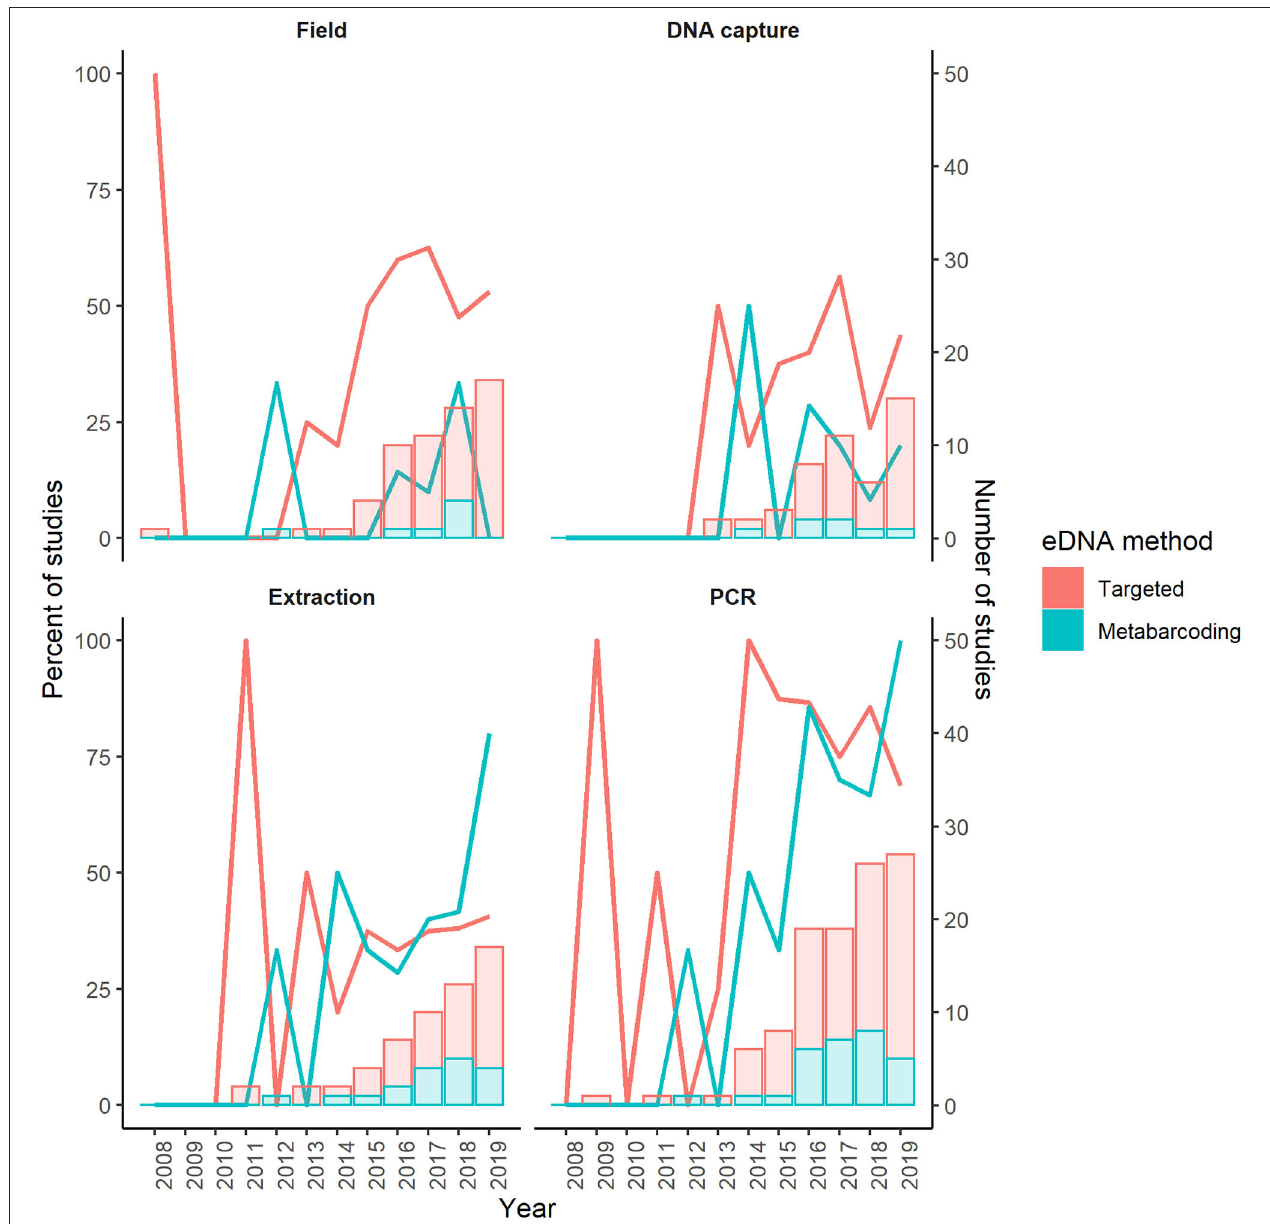
FIGURE 2 | Temporal trends in the percent of studies with reported negative controls associated with field, DNA capture, extraction, and PCR workflow steps in targeted and metabarcoding eDNA studies in the first literature review. Lines indicate the percent of studies and columns indicate the number of studies for a given